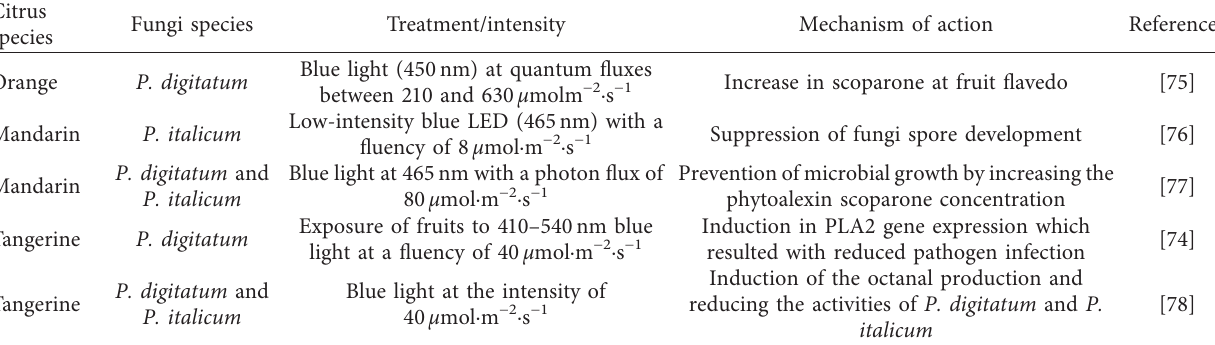
Table 4: Effects of blue light irradiation on the postharvest rotting caused by P. italicum and P. digitatum